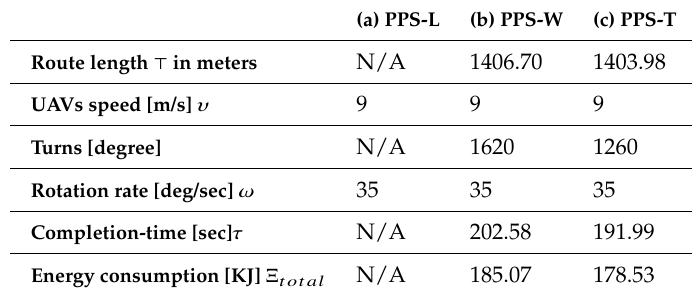
Table 11. Our CPP using our PPS-L partition method vs. PPS-W partition method vs. PPS-T partition method.